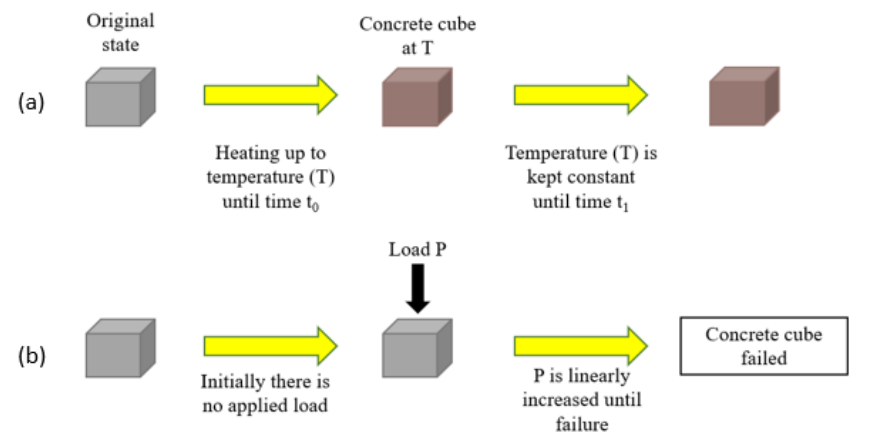
Figure 1. ( a ) Heating and ( b ) loading schemes of the stressed condition.